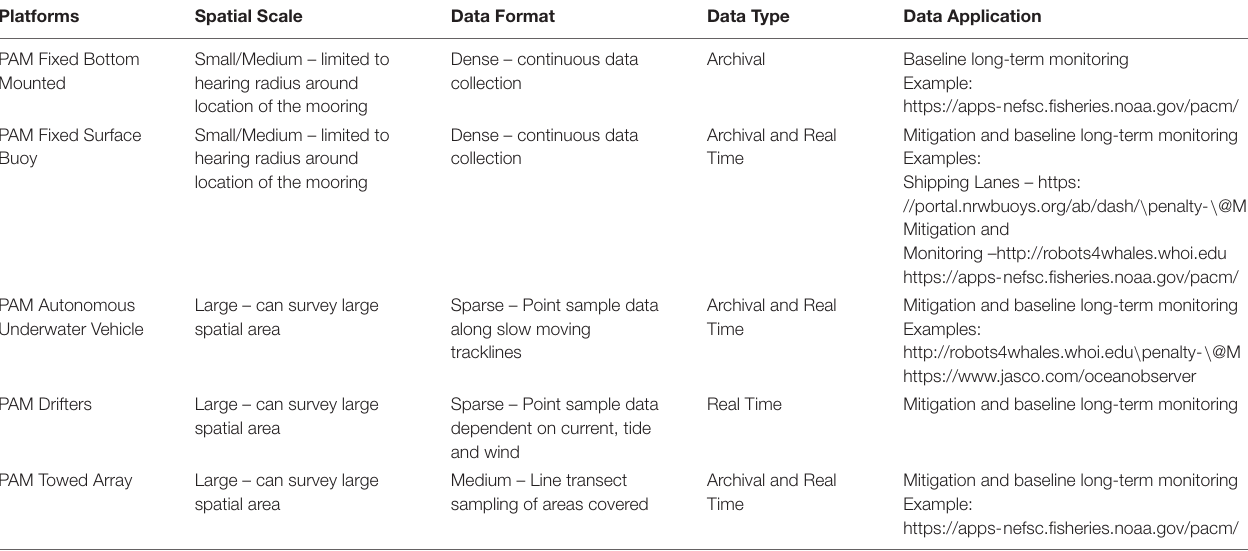
TABLE 3 | A list of the PAM platform types that are currently used for the collection of data for monitoring or mitigation purposes, the spatial scale over which they can collect data, the format and type of data collected, and the current applications in which they have been used to date.